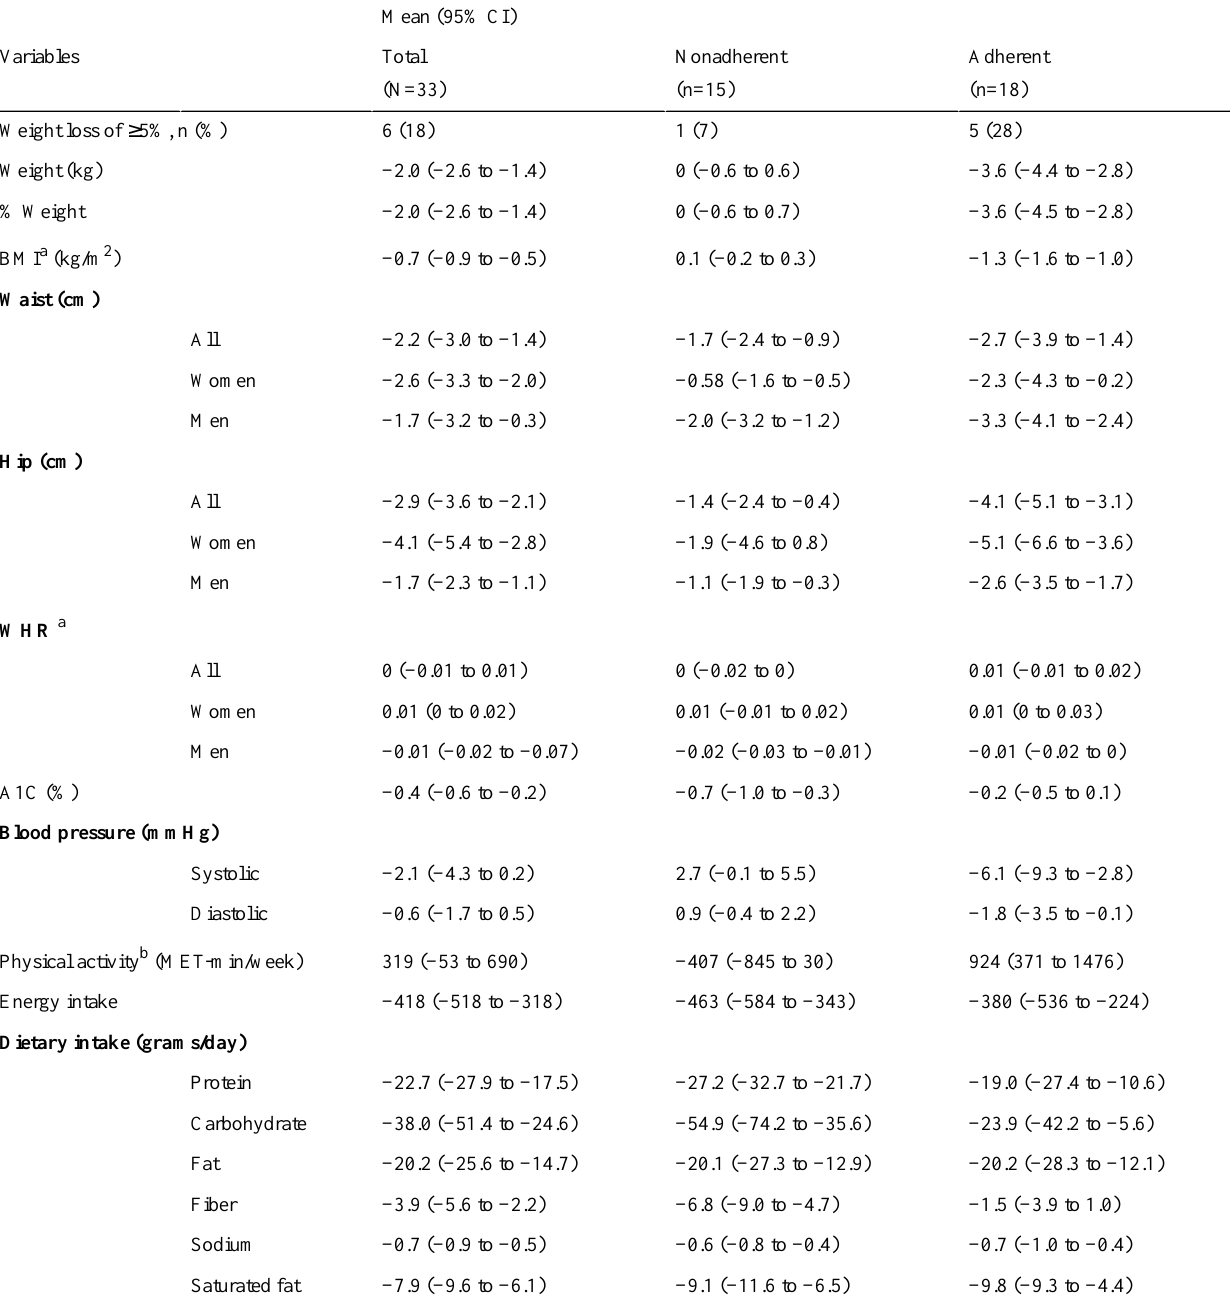
Table 2. Changes overall and stratified by adherence and